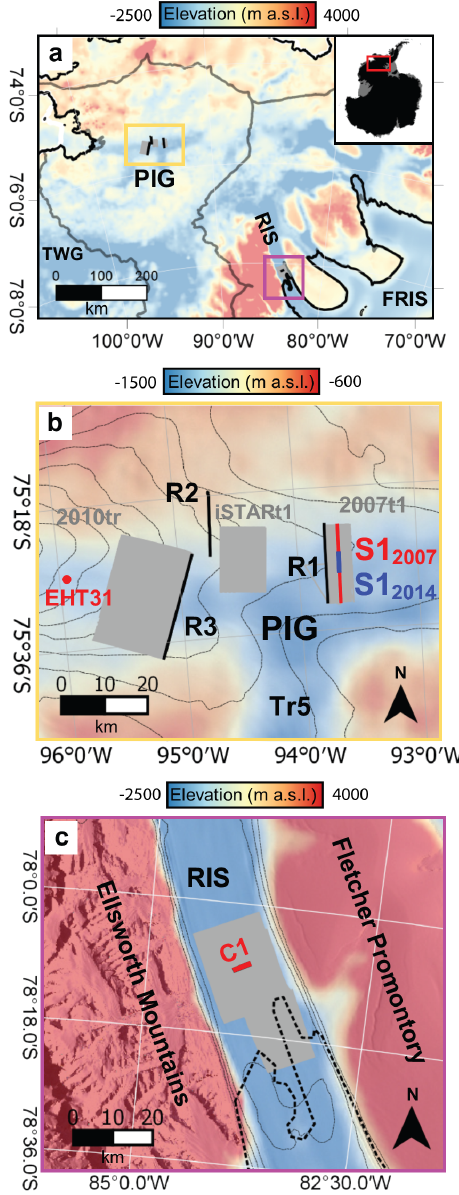
Figure 1. Location maps of the study area. Colour scale shows BEDMAP2 bed elevation (Fretwell et al., 2013). (a) Map of the Pine Island Glacier (PIG) and Rutford Ice Stream (RIS) catchments. Grey lines show drainage boundaries (Zwally et al., 2012). (b) Lo- cation of PIG surveys. Grey contours are 100ma − 1 ice surface ve- locity contours (Rignot et al., 2011). Grey shaded boxes show the locations of radar grid DEMs in Figs. 2a, 3a and 3f, black lines are repeat radar surveys. S1 2007 is a seismic survey presented in Smith et al. (2013) and S1 2014 is a section of this profile resurveyed in 2014 (presented in Brisbourne et al., 2017). EHT31 is a single point repeat survey presented in Smith et al. (2012). (c) Location of RIS surveys. Thick dashed line represents the MODIS grounding line. Grey contours are 100ma − 1 velocity contours (Rignot et al., 2011). Grey shaded box is the area of the radar grid DEM in Fig.